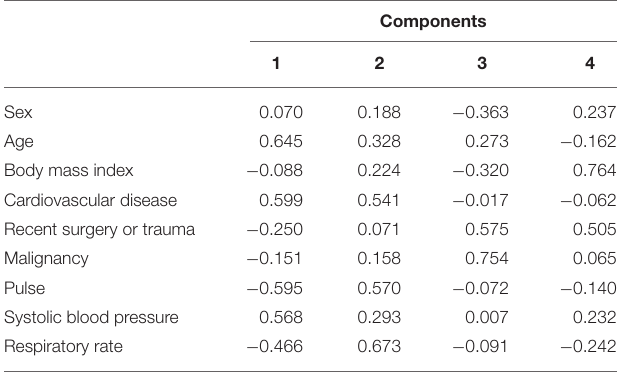
TABLE 3 | Correlations of the nine original variables with the four main components derived from the principal component analysis in the 725 PE patients with